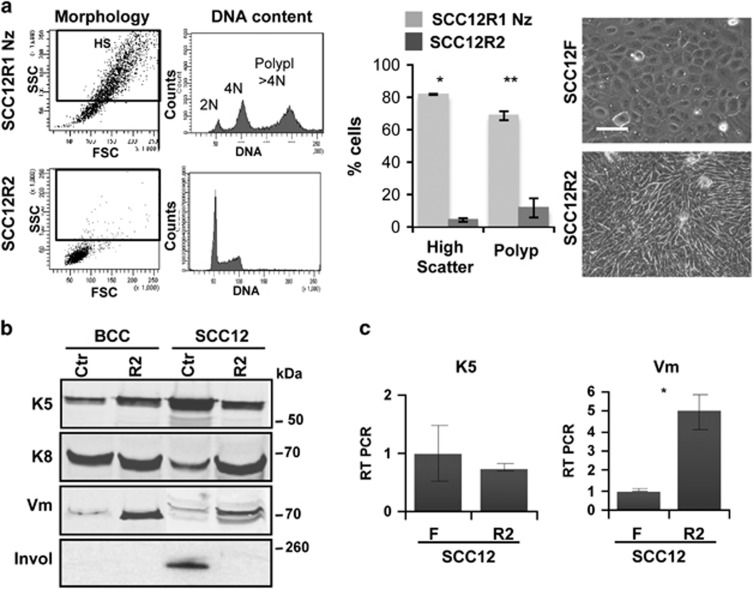
Two consecutive Nocodazole mitotic blocks drive a phenotypic conversion in SCC12F cells. (a)Left plots: representative flow-cytometry analyses of morphology (light scattering) and DNA content (propidium iodide) of SCC12R1 immediately after a second 48 h Nocodazole (Nz) treatment (SCC12R1Nz), or cells growing after treatment release (SCC12R2). Black square in dot plots gates cells with high light scatter (HS). Middle: bar histogram shows percent of SCC12R1Nz cells (light grey) or SCC12R2 cells (dark grey) with high scatter or polyploid (Polyp, DNA content >4N). Right: phase contrast microphotographs of parental SCC12F and SCC12R2 as indicated. Scale bar, 50 μm. (b) Western blotting for the expression of keratin K5, keratin K8, vimentin (Vm) or involucrin (Invol) in insoluble extracts of untreated BCCP or SCC12F (Ctr), or after a second Nz treatment release (R2). Same number of cells per lane. See also Supplementary Figure 8b. Invol lanes for Ctr are the same as in Figure 1c. Uncropped blots are shown in Supplementary Figure 12. (c) Quantitation of the expression of keratin K5 or vimentin (Vm) in SCC12F and SCC12R2 by real-time (RT)-PCR. See also Supplementary Figure 8b. Error bars are s.e.m. of duplicate samples of at least two independent representative experiments. *P<0.05, **P<0.01